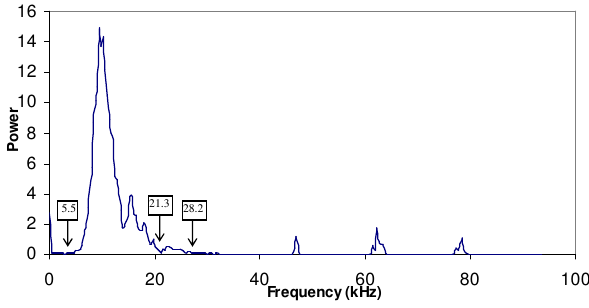
Fig. 4. The power spectrum of the sferic. Figure 4. The power spectrum of the sferic.